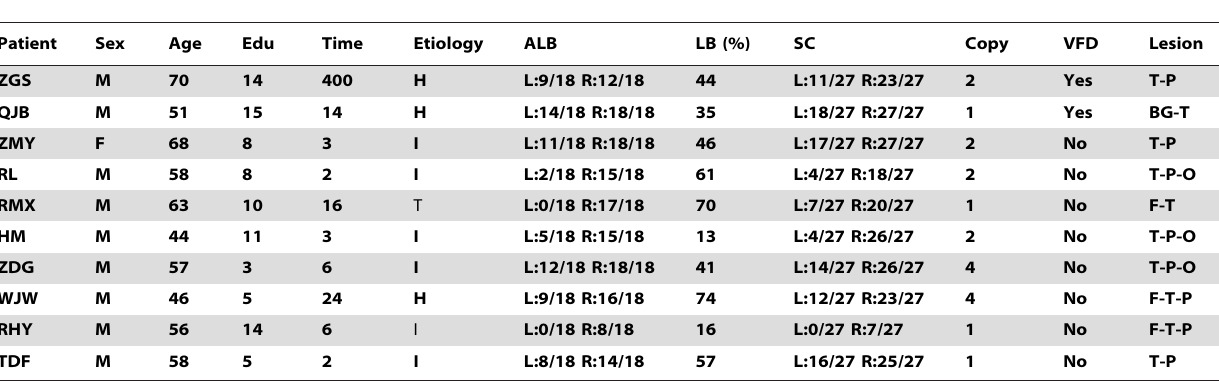
Table 1. Demographic and clinical characteristics of hemispatial neglect